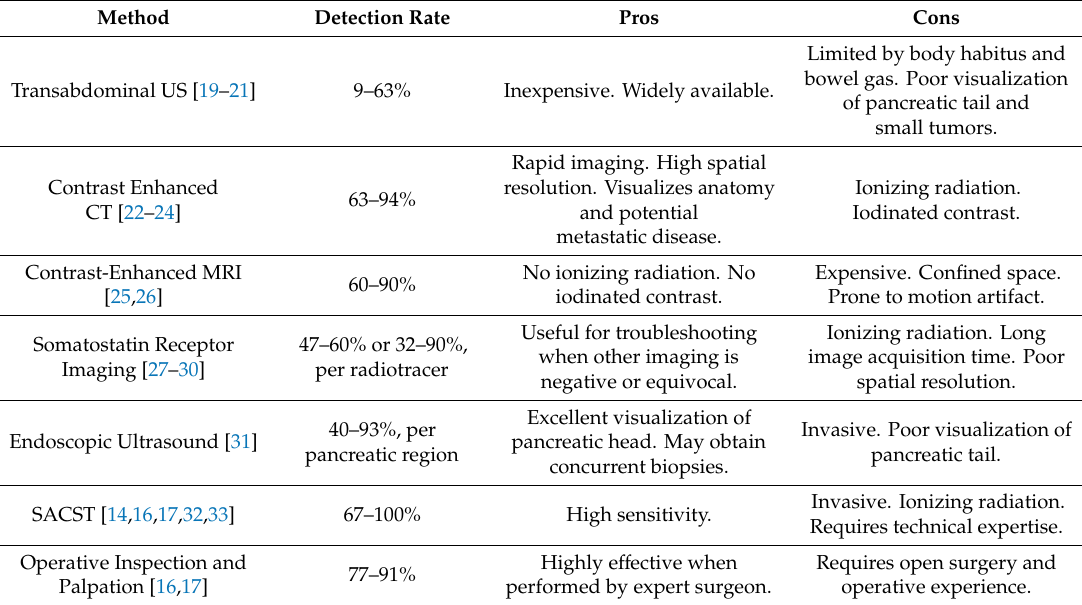
Table 1. Summary of localization